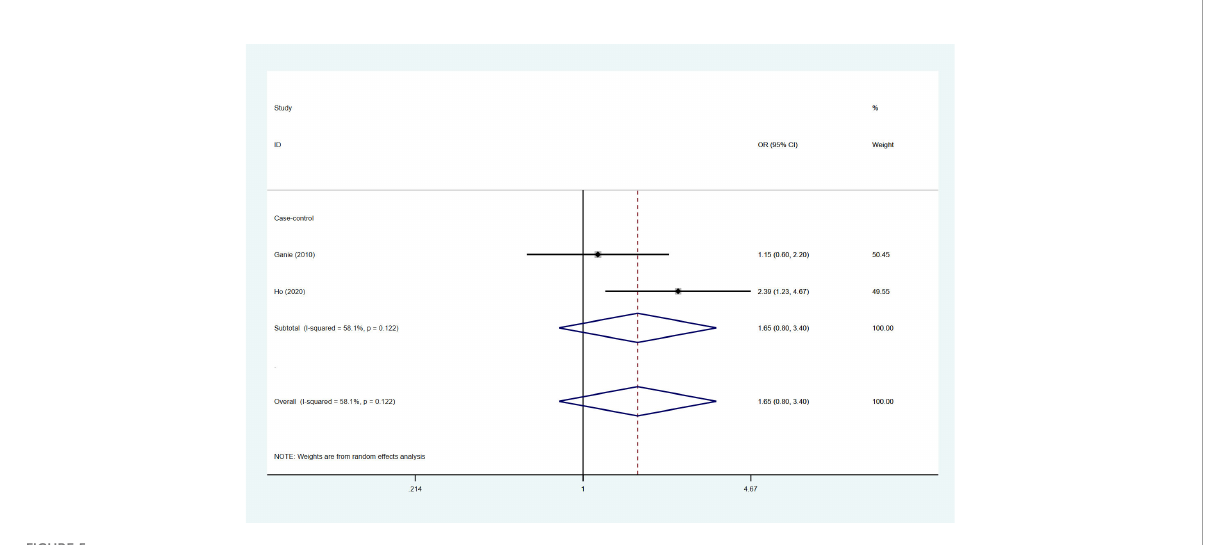
FIGURE 5 Forest map of PCOS risk in HT patients and non-HT